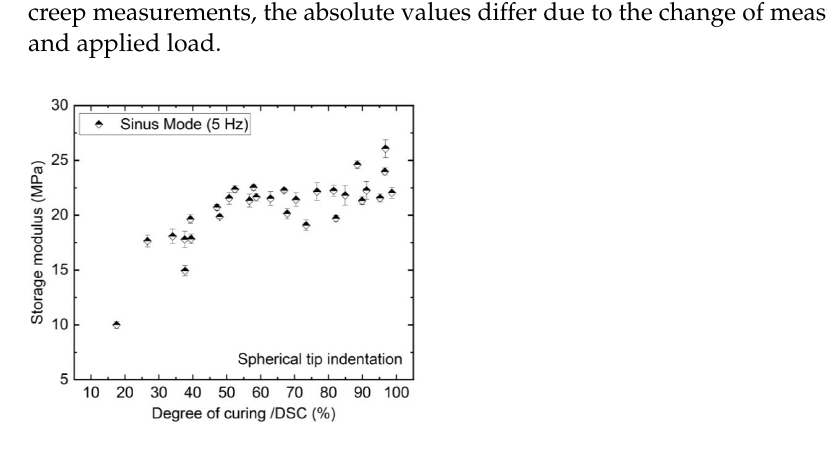
Figure 13. Storage modulus (calculated from the sine part of the dynamic curves) of the EVA surface as a function of 30 different DoCs as measured by